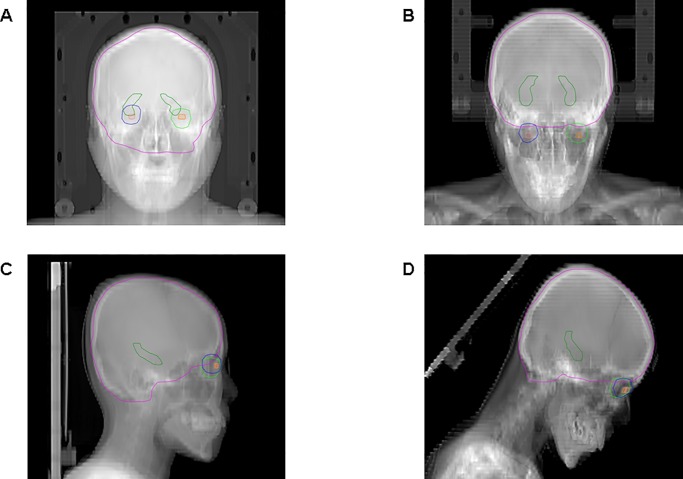
Scout image of volumetric-modulated arc therapy.(A) anterior and (C) lateral of the supine position, (B) anterior and (D) lateral head-tilt position; PTV (purple), hippocampus (dark green), Rt eye (blue), Lt eye (green), Rt lens (pink), Lt lens (orange).